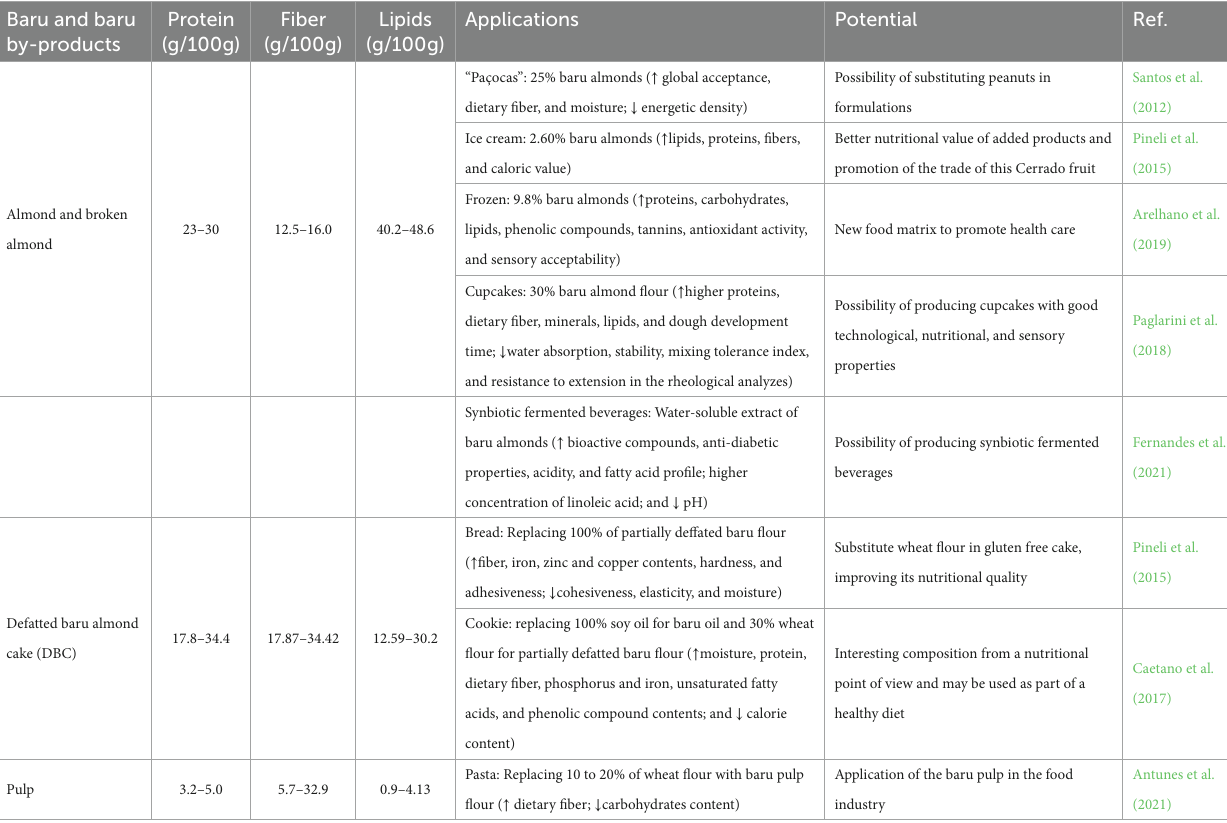
TABLE 1 Summarized mean values of protein, fibers, and lipids content: (as previously described in item 3) from the baru almond and baru by-products (DBC and pulp) and the potential applications in the development of food products. Baru and baru Protein Fiber Lipids Applications Potential Ref. by-products (g/100 g) (g/100 g) (g/100 g) “Paçocas”: 25% baru almonds ( ↑ global acceptance, dietary fiber, and moisture; ↓ energetic density) Ice cream: 2.60% baru almonds ( ↑ lipids, proteins, fibers, and caloric value) Frozen: 9.8% baru almonds ( ↑ proteins, carbohydrates, Almond and broken 23–30 12.5–16.0 40.2–48.6 lipids, phenolic compounds, tannins, antioxidant activity, almond and sensory acceptability) Cupcakes: 30% baru almond flour ( ↑ higher proteins, dietary fiber, minerals, lipids, and dough development time; ↓ water absorption, stability, mixing tolerance index, and resistance to extension in the rheological analyzes) Synbiotic fermented beverages: Water-soluble extract of baru almonds ( ↑ bioactive compounds, anti-diabetic properties, acidity, and fatty acid profile; higher concentration of linoleic acid; and ↓ pH) Bread: Replacing 100% of partially deffated baru flour ( ↑ fiber, iron, zinc and copper contents, hardness, and adhesiveness; ↓ cohesiveness, elasticity, and moisture) Defatted baru almond Cookie: replacing 100% soy oil for baru oil and 30% wheat flour for partially defatted baru flour ( ↑ moisture, protein, dietary fiber, phosphorus and iron, unsaturated fatty acids, and phenolic compound contents; and ↓ calorie content) Pasta: Replacing 10 to 20% of wheat flour with baru pulp flour ( ↑ dietary fiber; ↓ carbohydrates content)